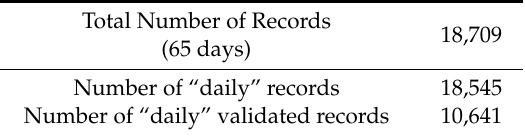
Table 1. Summary of observed data.